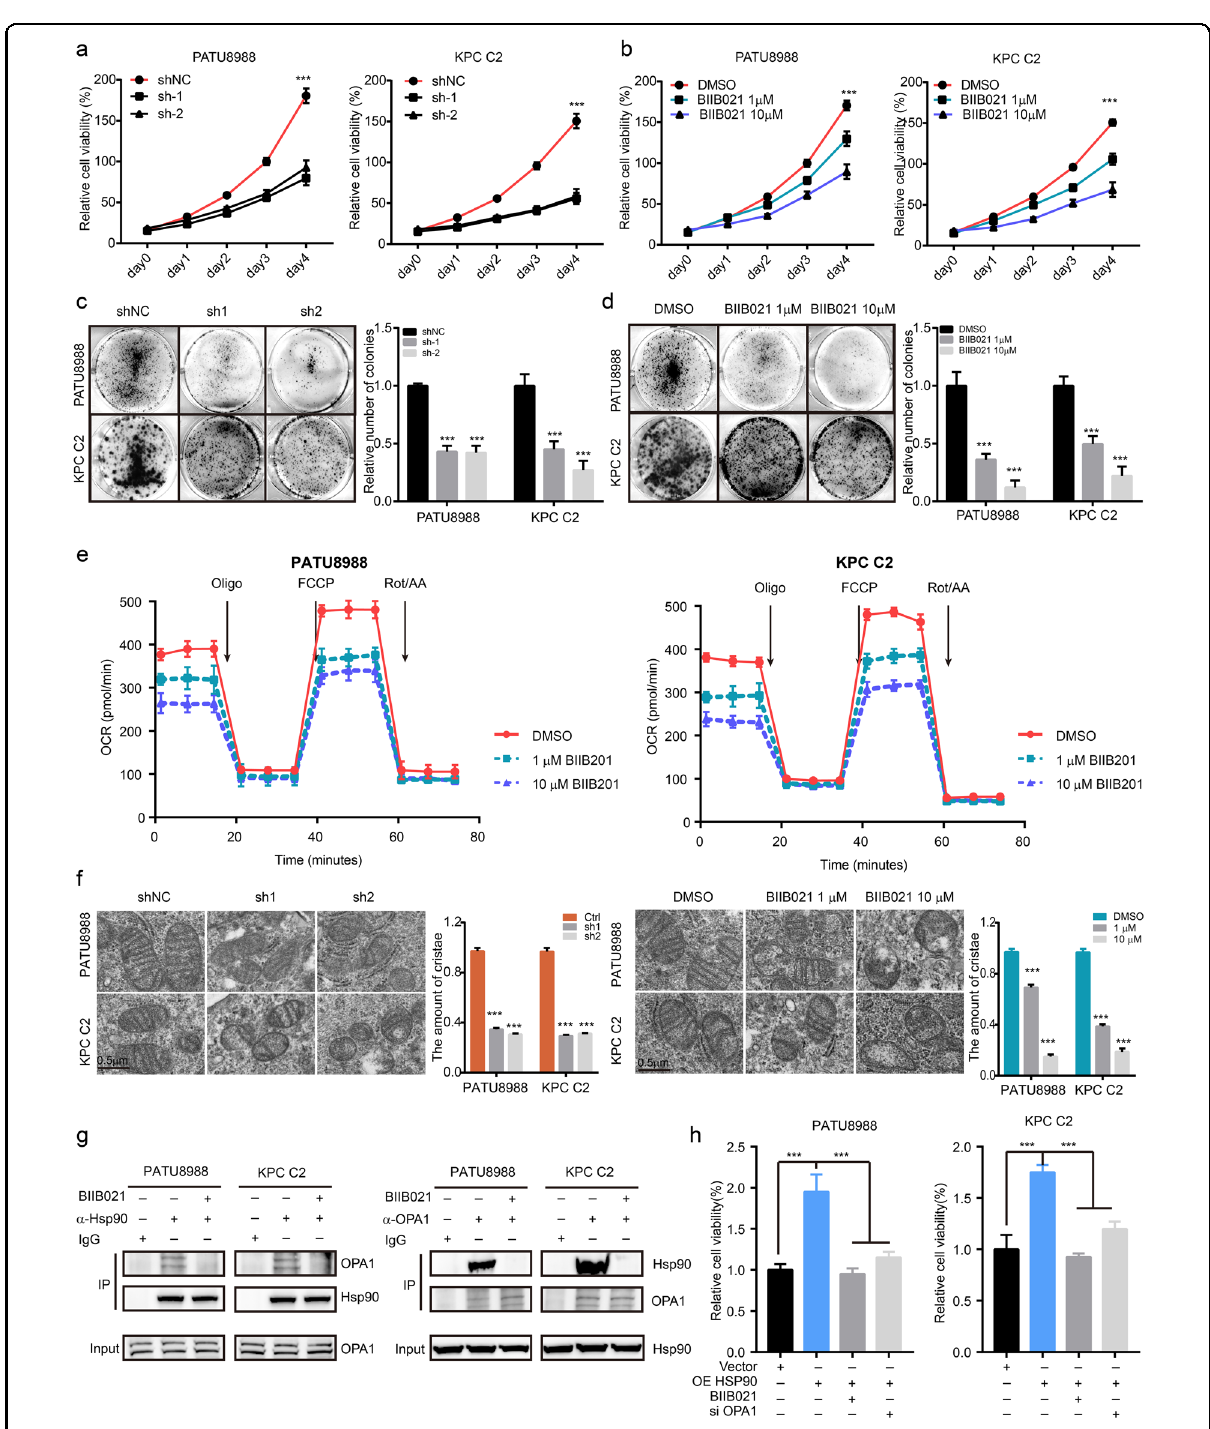
Fig. 3 HSP90 inhibition suppressed mitochondrial energy production in PDAC. a Relative cell viability of PATU8988 cells stably expressing shNC, shHSP90AA1-1 (named sh1), and shHSP90AA1-2 (named sh2) and relative cell viability of KPC C2 cells stably expressing shNC, sh Hsp90aa1 -1 (named sh1), and sh Hsp90aa1 -2 (named sh2). Statistical results vs. the shNC group. b Relative cell viability of PATU8988 and KPC C2 cells treated with DMSO, 1 μ M BIIB021 or 10 μ M BIIB021. Statistical results vs. the DMSO group. c Colony formation assay of PATU8988 and KPC C2 cells stably expressing shNC, sh1, and sh2. d Colony formation assay of PATU8988 and KPC C2 cells treated with DMSO or different doses of BIIB021. e OCR measurement in human and mouse PDAC cells treated with DMSO, 1 μ M BIIB021 or 10 μ M BIIB021. f Morphometric analysis of mitochondria with transmission electron micrographs upon HSP90 inhibition. g Coimmunoprecipitation of HSP90 and OPA1 in PDAC cell lines treated with or without BIIB021 for 24 h. h Cell proliferation assay of PDAC cells with HSP90 overexpression plus BIIB021 or OPA1